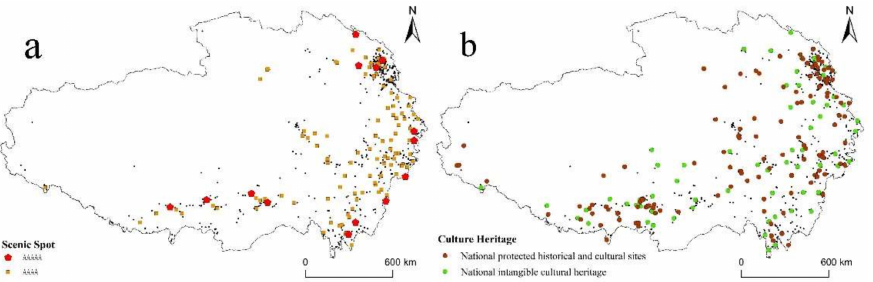
Figure 12. Spatial distribution of RT villages coupled with tourism resource: ( a ) scenic spots; ( b ) cul- ture heritage.